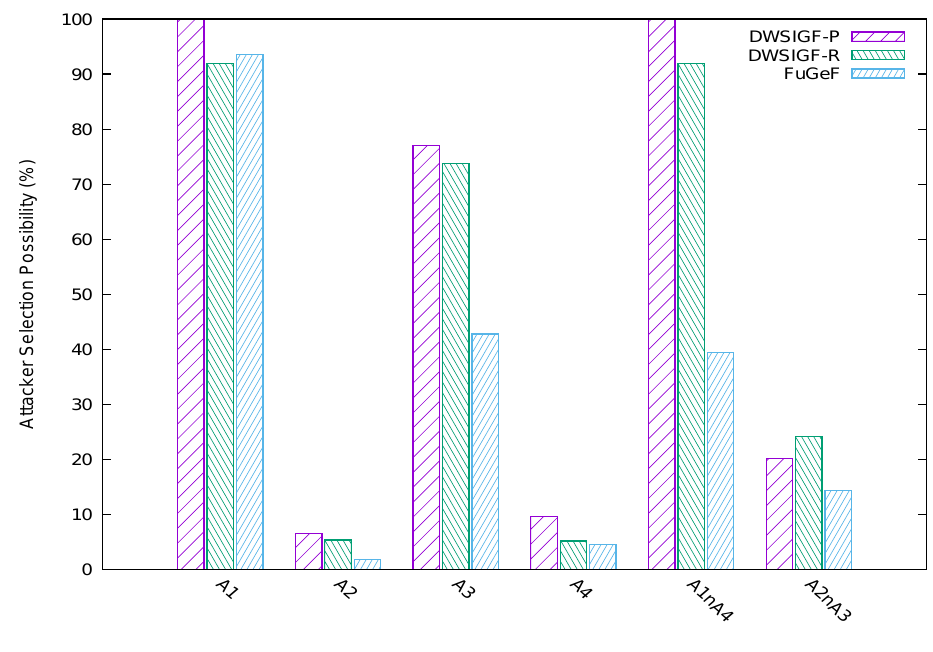
Figure 7. Possibility of attacker